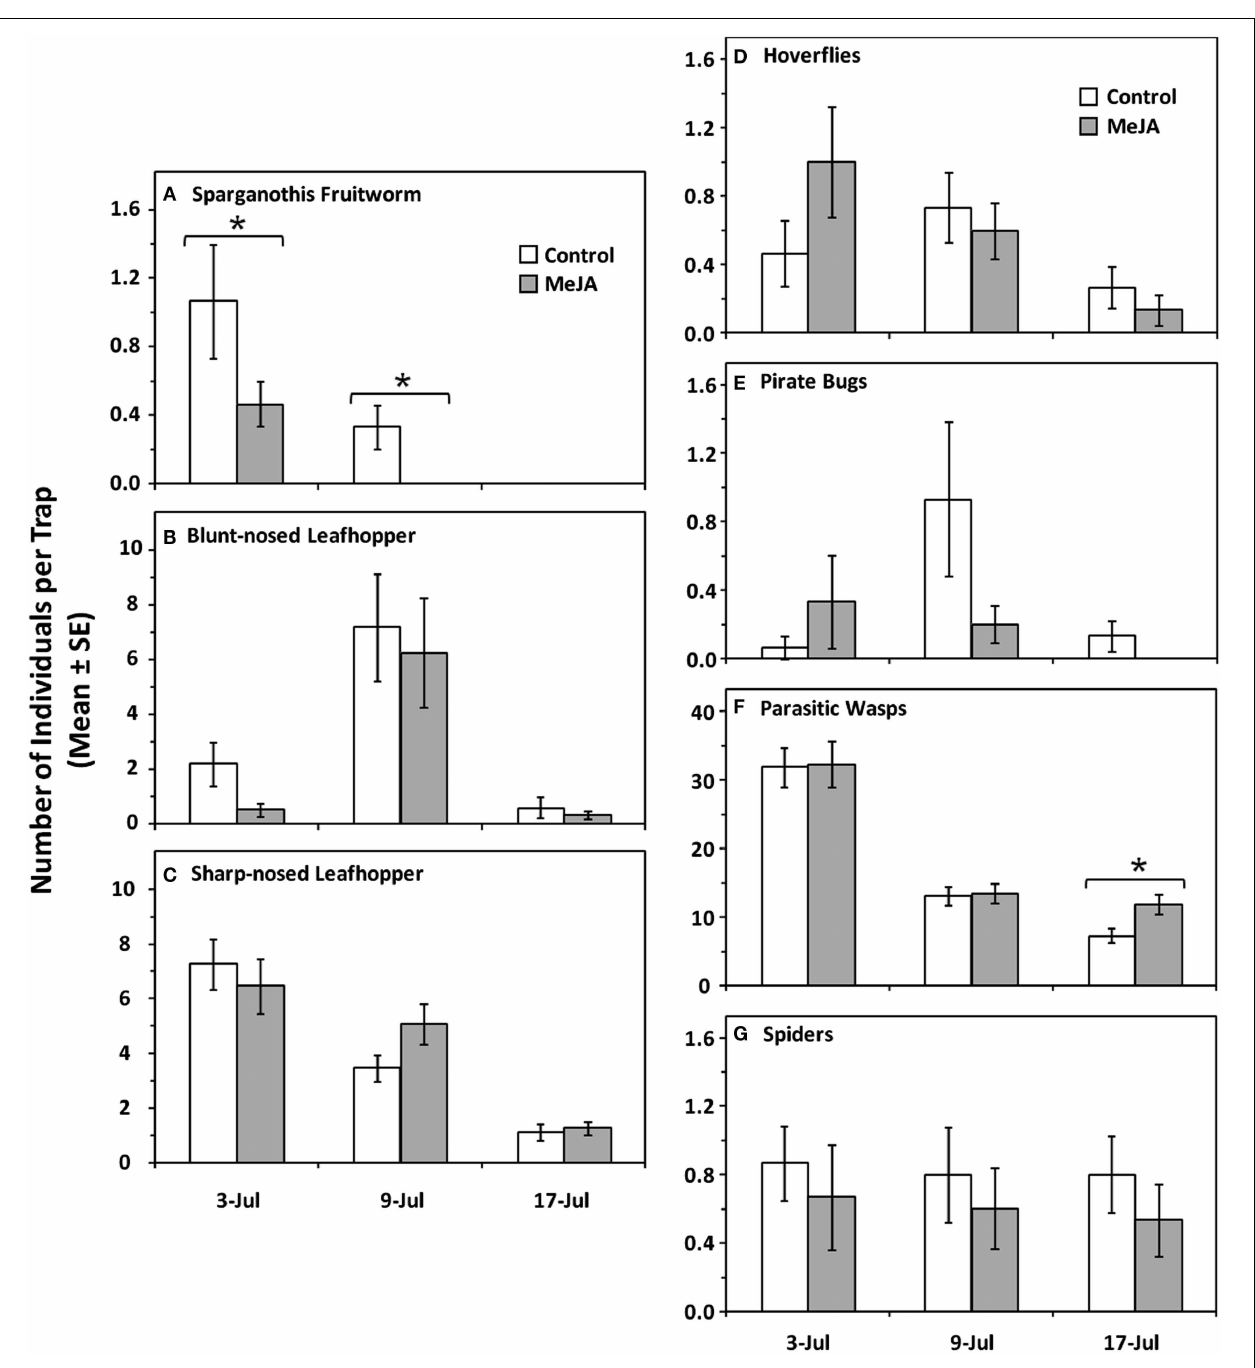
Cicadellidae). Natural enemies: (D) hoverflies (mainly Toxomerus marginatus ) (Dip., Syrphidae), (E) minute pirate bugs ( Orius spp.) (Hem., Anthocoridae), (F) parasitic wasps (Hymenoptera), and (G) spiders (Araneae). Asterisks ( * ) indicate statistically significant differences between MeJA and control treatments ( P ≤ 0.05); all other comparisons were non-significant ( P >